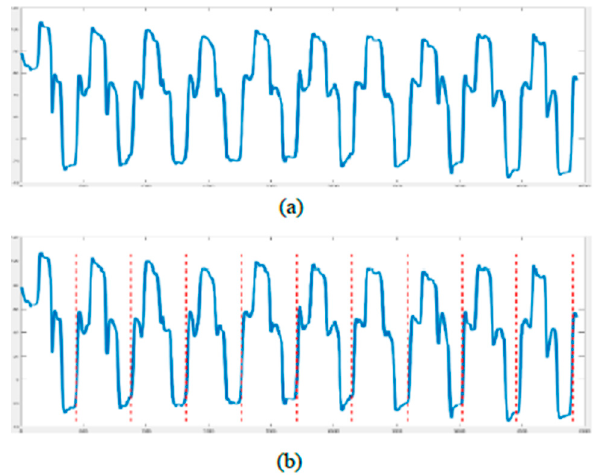
Figure 7. ( a ) Original signals. ( b ) Signals after partitioning.